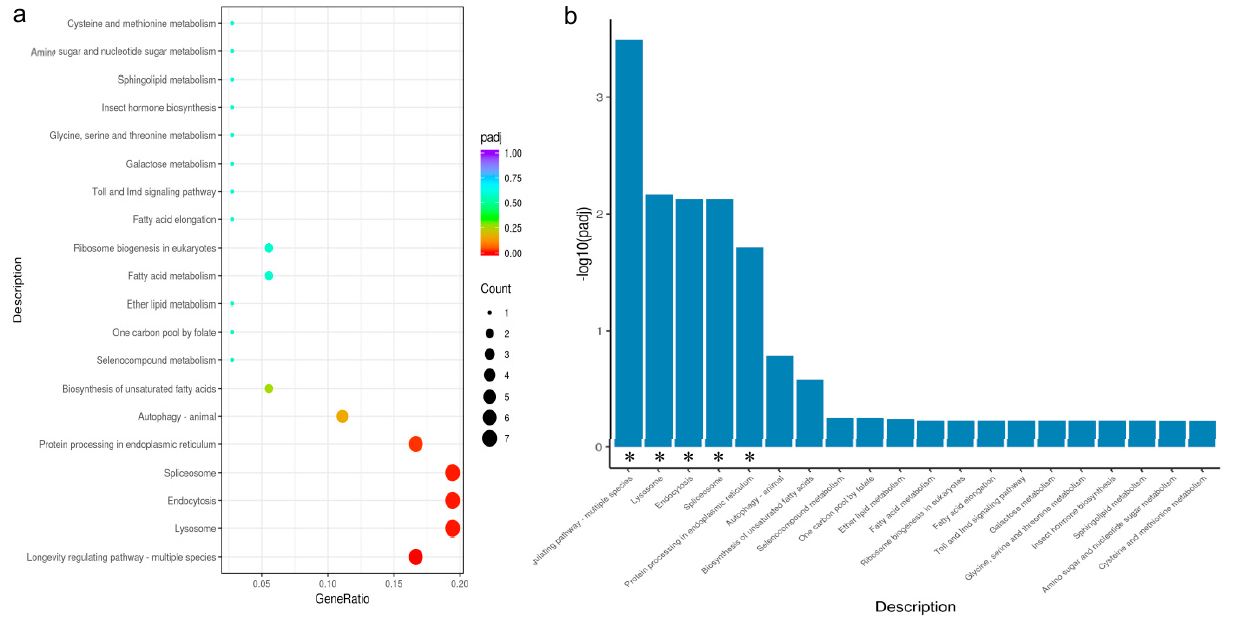
Figure 4. ( a , b ): Scatter and bar Chart of KEGG enrichment analysis of DEGs, using padj < 0.05 as the threshold for significant enrichment. * Indicates that DEGS is significantly enriched in this pathway.